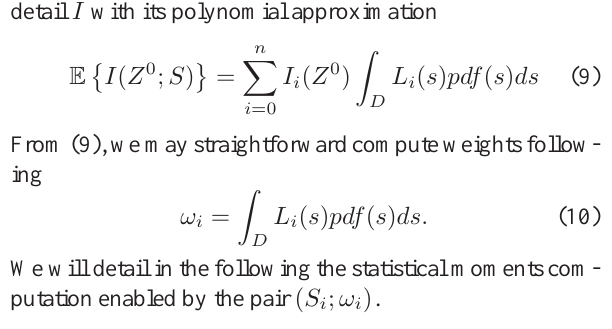
for 1-RV case with a i , ω i )